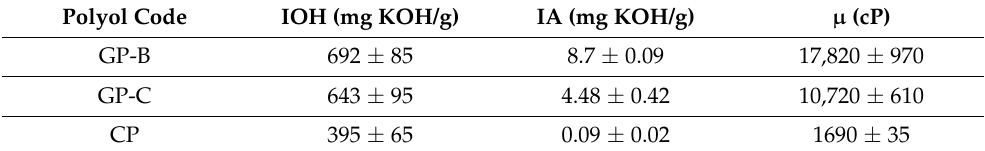
Table 5. Properties of the Green Polyols (GPs) obtained and properties of the Commercial Polyol (CP). Polyol Code IOH (mg